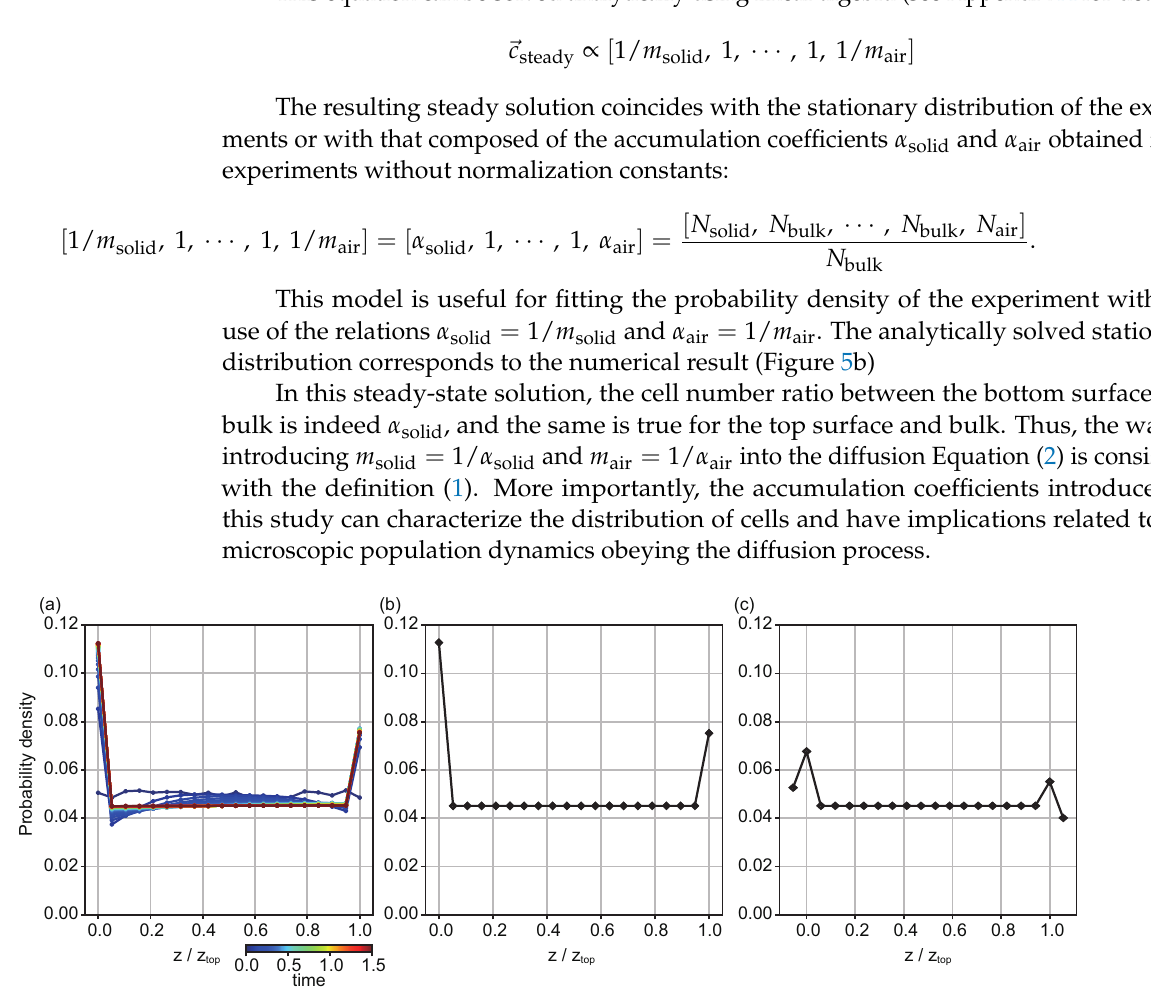
Figure 5. ( a ) Time evolution of the diffusion equation model by numerical simulation, where D = 0.001, ∆ z = 0.05, ∆ t = 0.005, and T = 300. The simulation starts with a random initial distribution and asymptotes to a bimodal stationary solution. ( b ) Analytical solution corresponding to the steady state of the system (cid:126) c steady . ( c ) An example of the apparent distribution of cells considering the experimental setup generated by convoluting the analytical solution shown in ( b